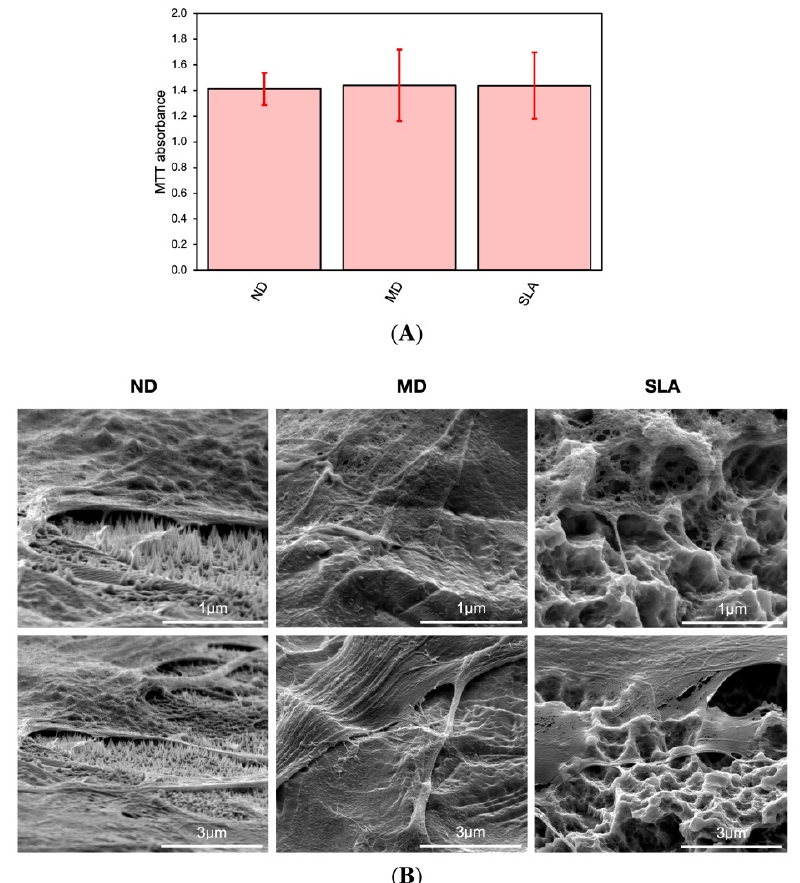
Figure 5. ( A ) Comparison of ND, MD, and SLA in the MTT assay. HGF cells were cultivated on discs for 72 h, and their viability was tested via MTT assay. Three independent experiments were performed in triplicate; n = 3, error bars represent SD. X-Axis: ND, MD control, SLA control. ( B ) SEM images of HGF-1 after 24 h on the tested materials: ND, MD, SLA. Abundant filopodia attachments were found on all samples. Portions of the HGF-1 cytoplasm exhibited a reticulated appearance. Through its sharp shape, the nanospike structure appears to perforate the fibroblast at some spots.